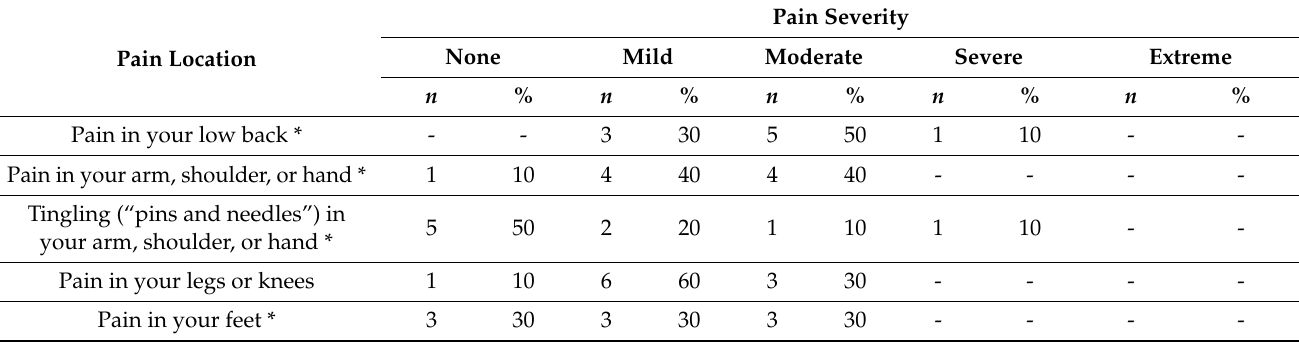
Table 3. Pain location and severity among workers with musculoskeletal pain in the last 7 days ( n =